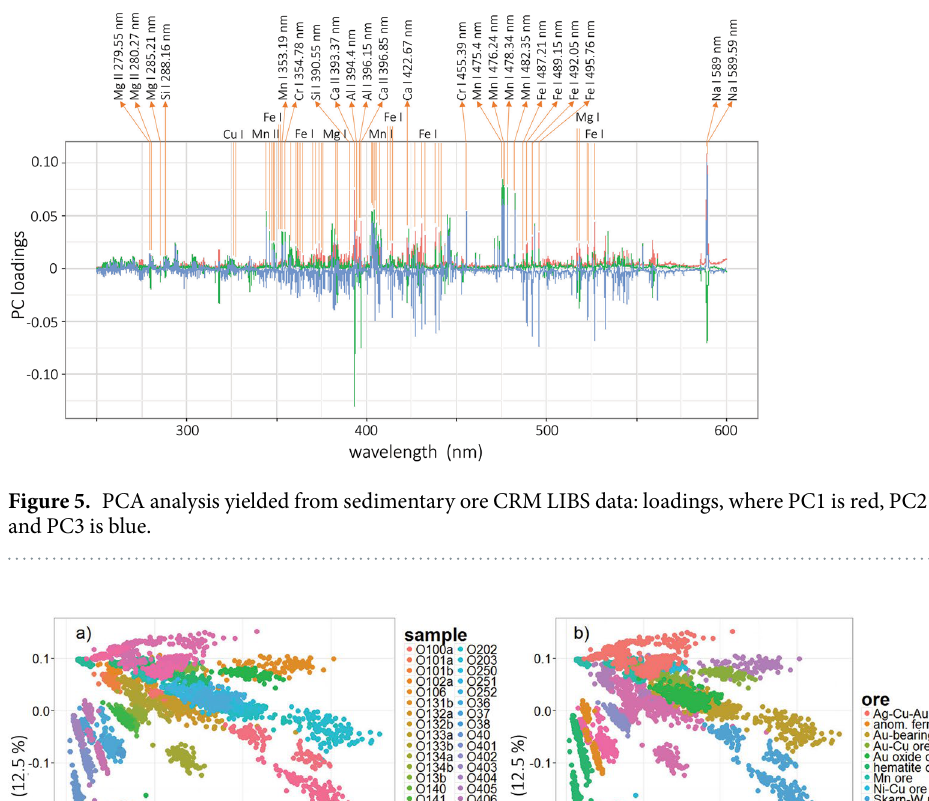
matrix, where rows (5000 in total) were assigned to individual melted echellogram images/measurements and columns were pixels/variables. However, a matrix of those dimensions could not be processed in the R software, installed on an office PC with 32 GB of RAM. To reduce the dimensionality, the echellograms were cropped, and their bottom parts were sacrificed for the sake of computation. However, even after doing so, it was not possible to estimate PCA scores and loadings for the truncated data matrix even. Therefore, PCA analysis of the echellogram images, without variable down-selection, is missing. The selected 225 data points/pixels from the echellograms significantly reduced the dimensions of the data matrix. Afterwards, the computation was naturally faster and less extensive. The first two PCA scores estimated from the data matrix are depicted in Fig. 6. The PC space was depicted for data distributed according to a) samples and b) ore types. When the distribution according to the ore type is considered for more descriptive investigation, the data are scattered in the PC space in more compact and distinctly separated clusters. This is in strict contra- diction to the results observed when the 1D spectra were under investigation in PC space, Fig. 4. This suggests that selecting the most informative pixels is beneficial for data processing. The first three principal components describe ~46% of the total variance. This is much more than in the previous case where 1D spectra were coupled to PCA. The higher variance is obtained because of the lower number of variables and the absence of noise. PCA analyses of the data sets constructed from 86 or 21 pixels are not provided in this manuscript. In the last step of our analysis, the obtained LIBS data, 1D spectra and the data points selected from echel- lograms using the proposed approach were classified utilizing linear (L2R LR) and non-linear (SVM) MVDA algorithms. The classification accuracy for each case was proposed as a figure of merit and was estimated from confusion matrices. The obtained results are summarized in Table 1. The non-linear algorithms yielded slightly higher accuracy, which was expected and is also in agreement with literature 20 . This table was constructed for the results obtained for data distributed to classes according to sample (50) and respective ore type (13). The overall trend shows that classifying the data according to ore type yields higher accuracies, regardless of the MVDA algorithm used. This relates to the fact that data from the samples of the same ore type slightly overlap, which may cause misclassification. Most falsely classified data were recorded with classes that are relatively close to each